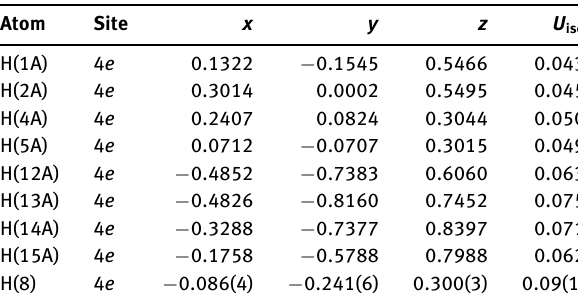
Table 2: Fractional atomic coordinates and isotropic or equivalent isotropic displacement parameters (Å 2